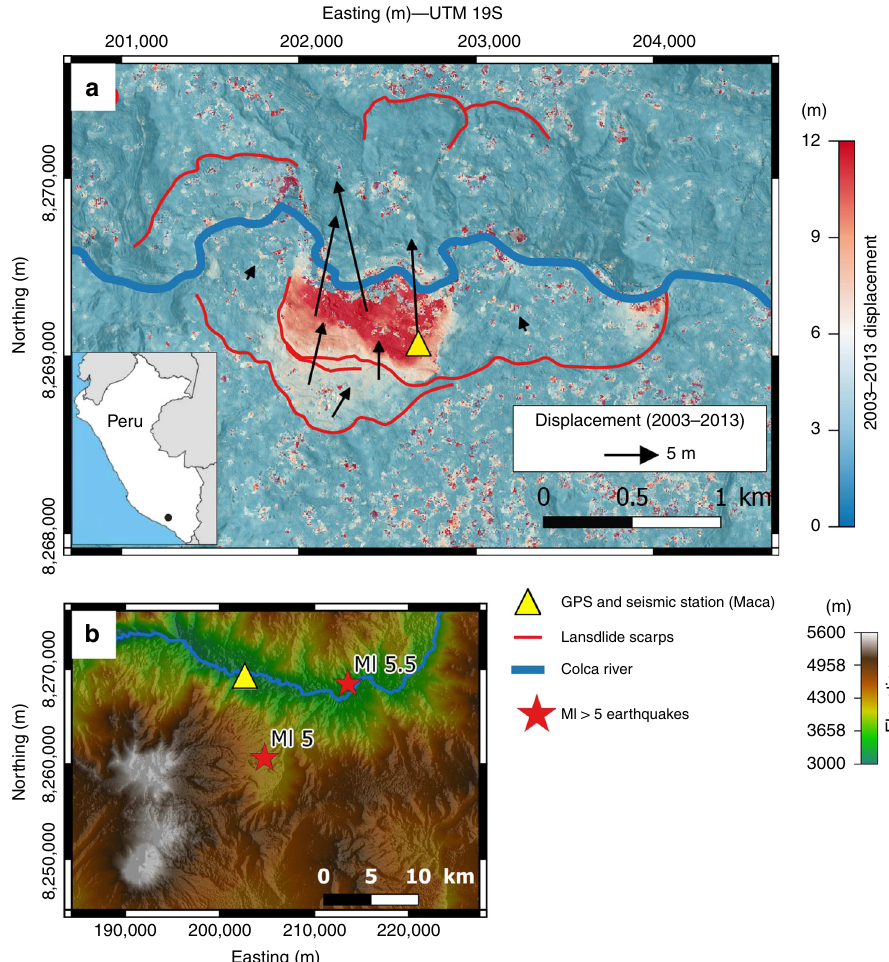
Fig. 1 The Maca landslide. a Cumulative displacement of the Maca landslide between 2003 and 2013 (from Bontemps et al. 18 ). b Digital elevation model of a part of the Colca Valley. The red stars represent the epicenters of the Ml 5.0 and the Ml 5.5 earthquakes that occurred on 20 February and 15 August 2016, respectively. The yellow triangle indicates the location of the hut housing the GPS and seismic station on the Maca